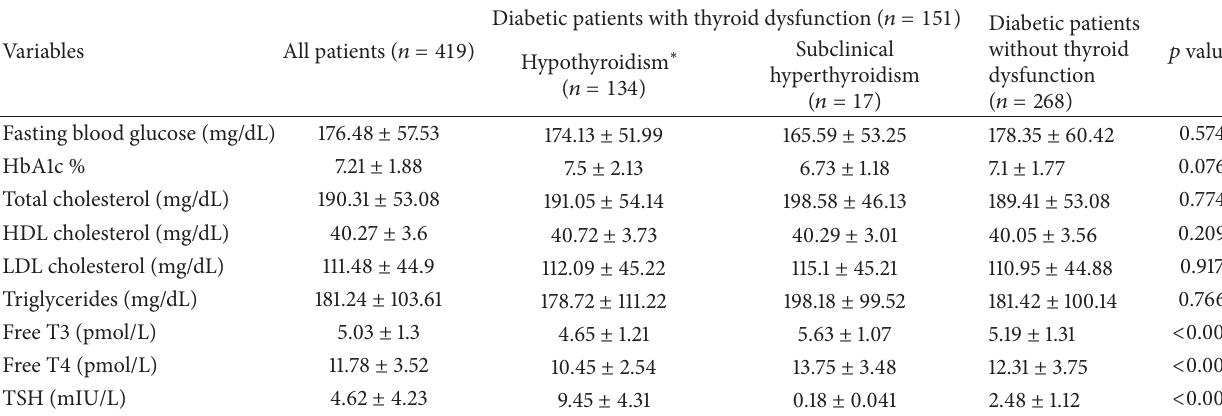
Table 2: Biochemical parameters in the study